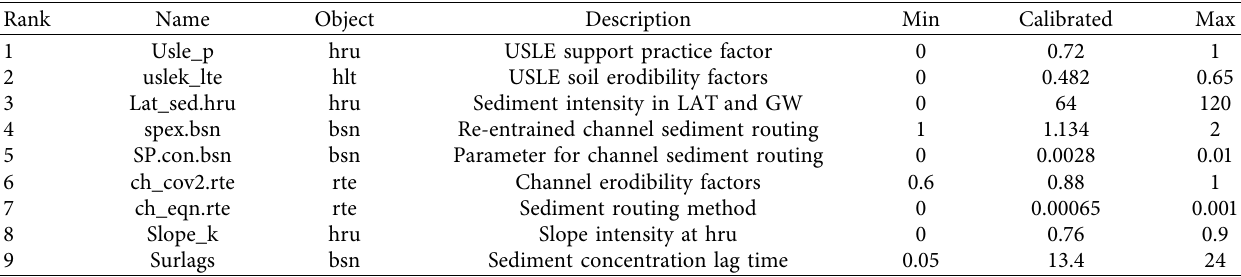
Figure 7: Streamfow calibration (a) and validation (b) for three consecutive scenarios. Table 9: Te calibrated values of sensitive